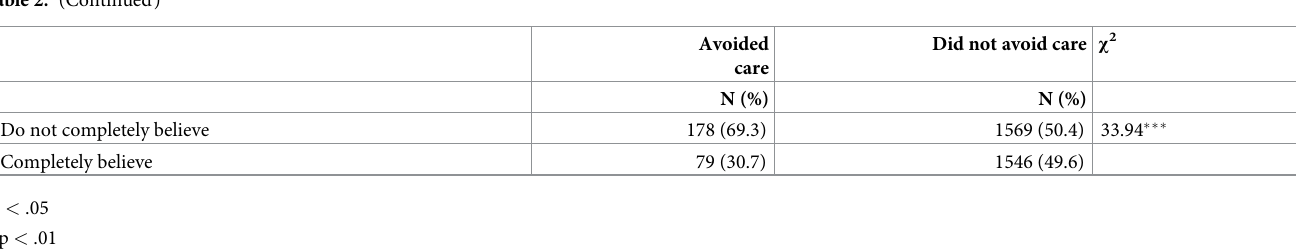
Nagelkerke R 2 . In the next step, the environment variable, discussing COVID-19 with family and friends, was not significantly associated with care avoidance but the three patient-related variables remained significant. The explained variance was 5.6% following step two. In step three, the institutional variables–lower healthcare organization experience ratings (OR 1.83,